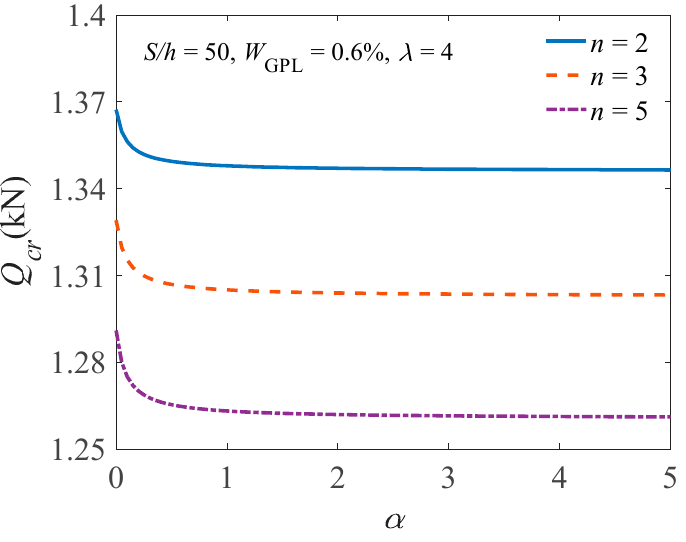
Figure 6. Effect of geometry and size of GPLs on the buckling load.